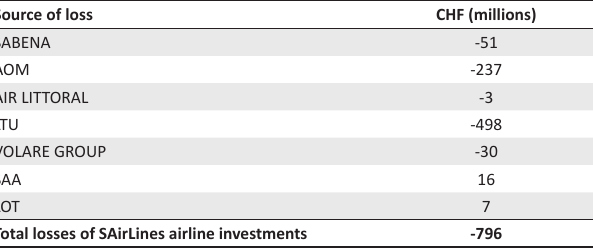
TABLE 3: Losses of SAirGroup Airline Investments for 2000 (associated companies).